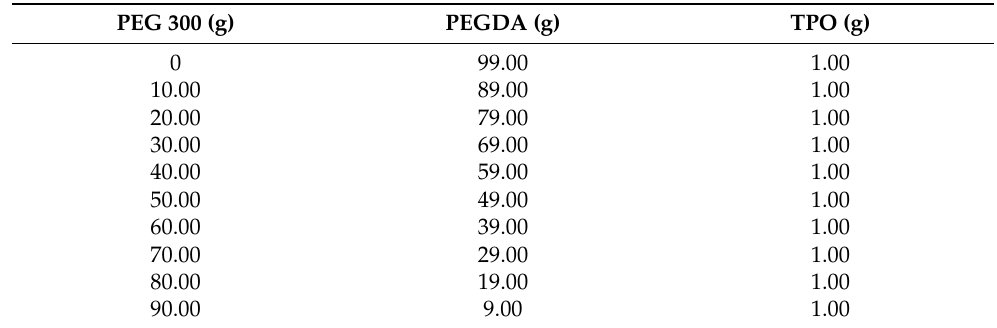
Table 1. The printing formulations with different ratios of PEG 300 and PEGDA.